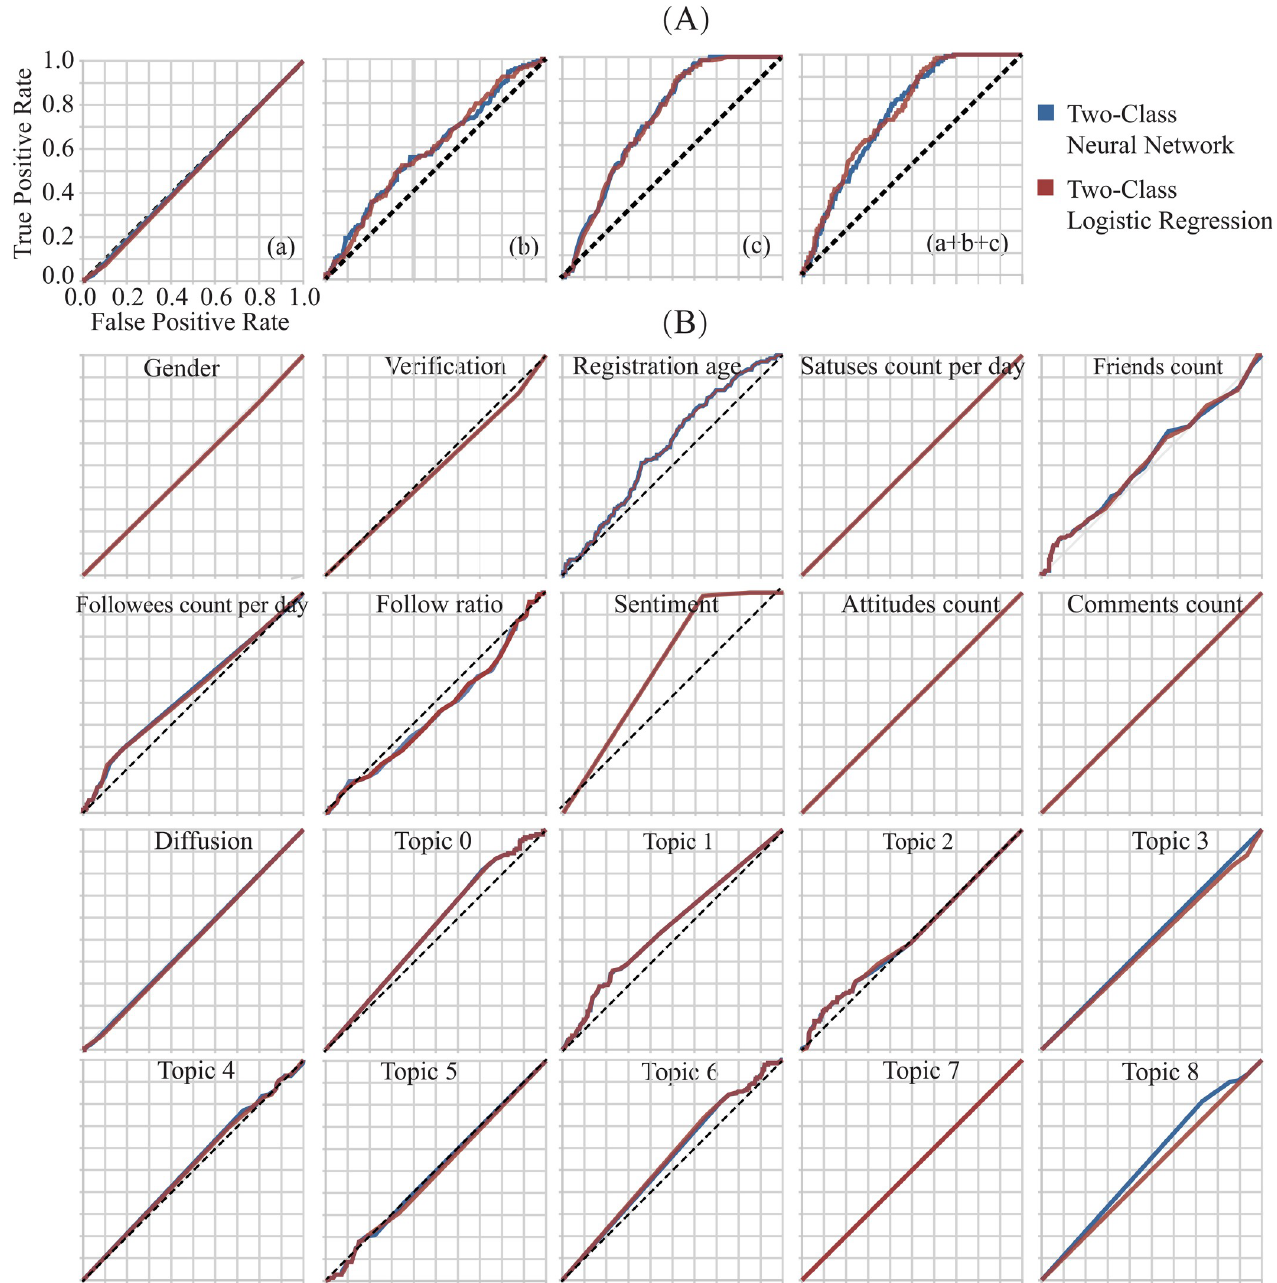
Fig 2. ROC curves for different features. (A) ROC curves for four sets: propagation related indicators (a), user identities (b), linguistic styles (c), and all the indicators (a+b+c). (B) ROC curves of the individual features. The red and blue lines overlap for most of the features.